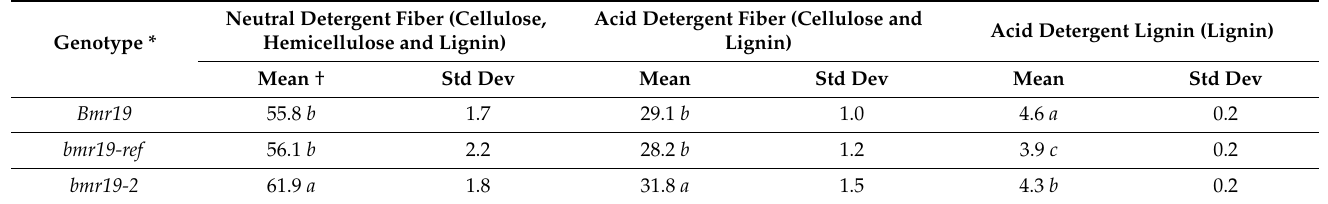
Table 4. Fiber analysis of field grown mutant ( bmr19 ) and wild type ( Bmr19 ) sorghum lines in the BTx623 background. Neutral Detergent Fiber (Cellulose, Genotype * Hemicellulose and Lignin)